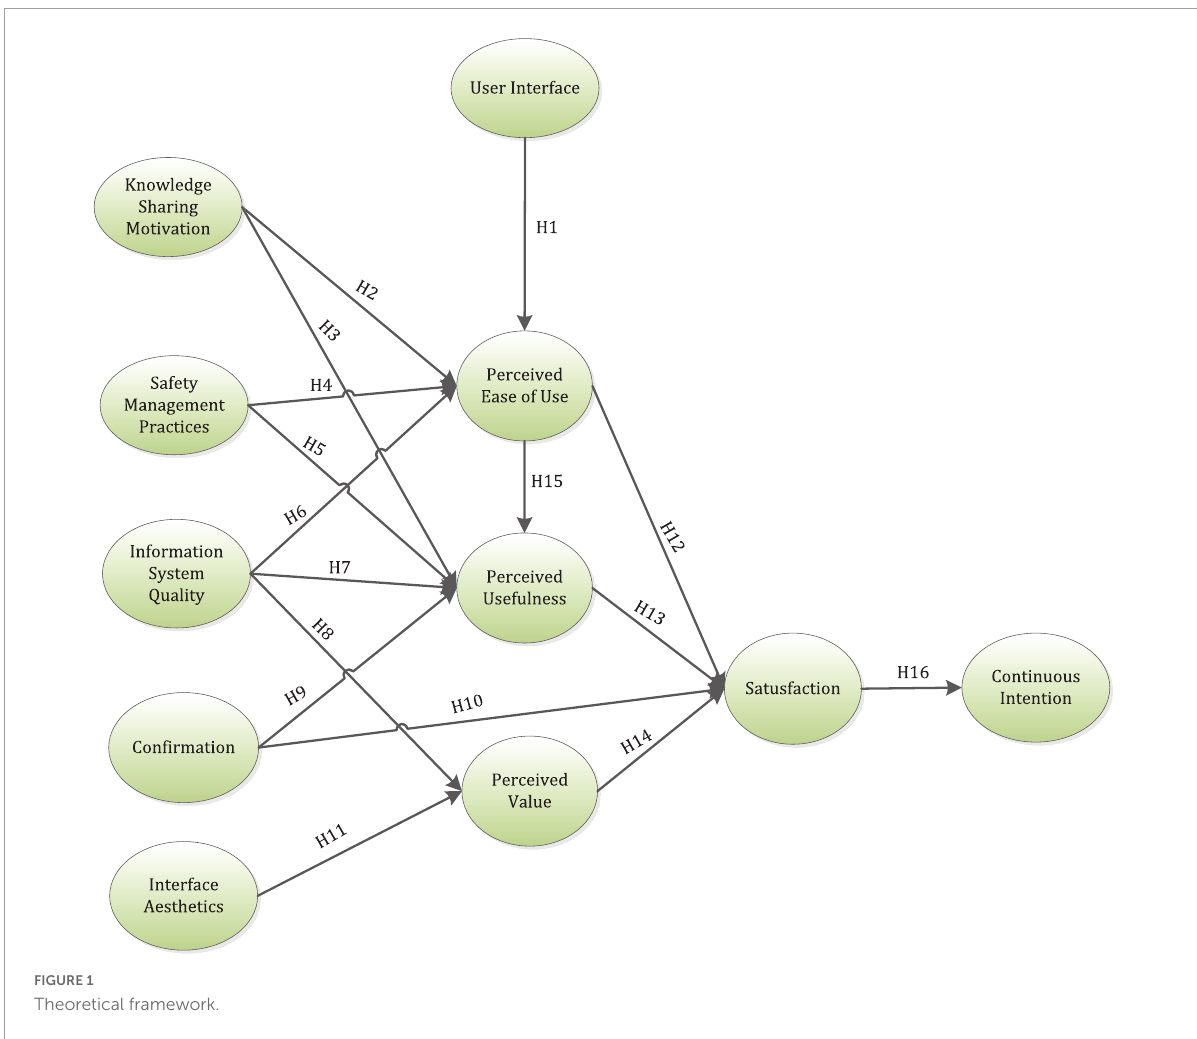
FIGURE1 Theoretical